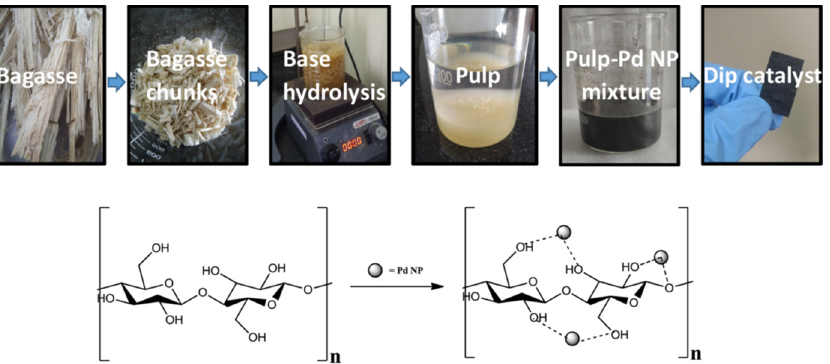
Figure 6. Preparation steps of the dip catalyst from sugarcane bagasse; representation of cellulose- supported Pd NPs proposed by Kandanthil et al. [59].